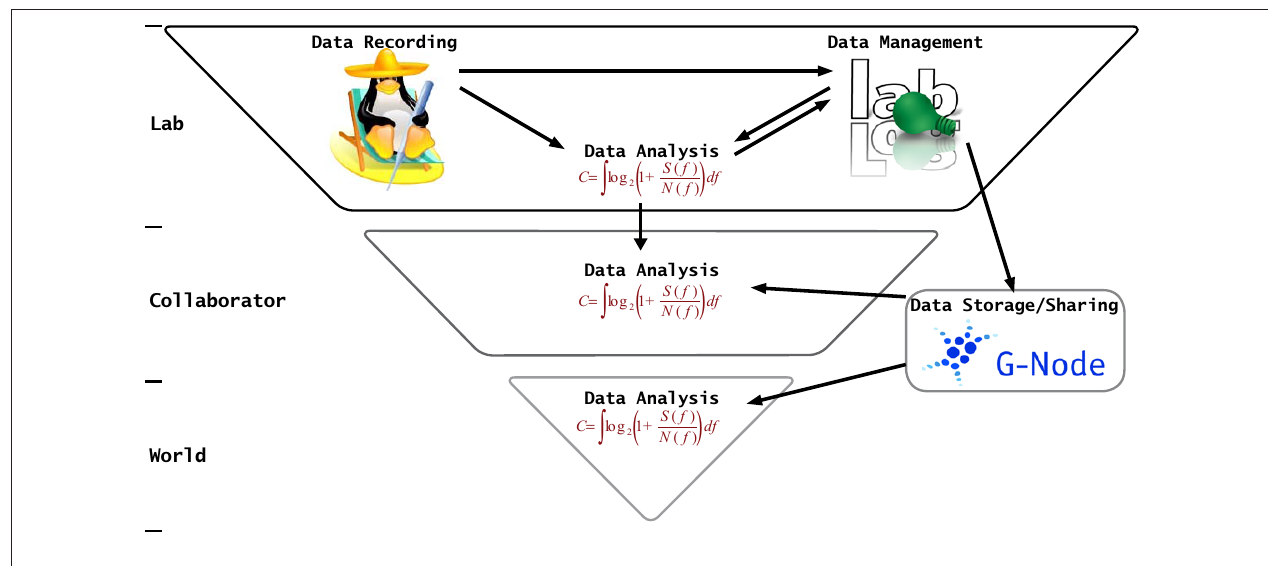
are added which again may be useful for querying data, etc. Data may further be shared with collaborators for discussion and re-evaluation. Eventually, data may be made available via public databases like the G-Node (Herz et al., 2008). On all levels data exchange between people as well as computer programs requires a detailed annotation of the raw data with